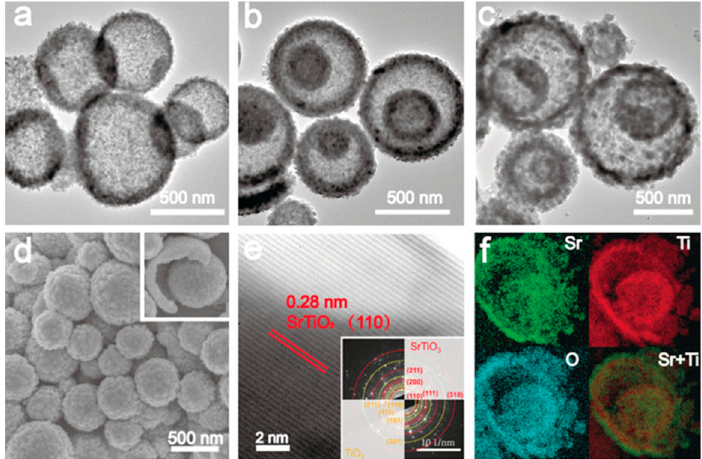
Figure 30. Morphological characterization of hollow multi ‐ shelled structures (HoMSs): TEM images of ( a ) single (1S ‐ ), ( b ) double (2S ‐ ), and ( c ) triple (3S ‐ ) shelled structures. ( d ) SEM image of 3S ‐ HoMSs (inset: broken sphere). ( e ) HRTEM image of SAED of S ‐ HoMSs (S ‐ HoMSs). ( f ) Elemental mapping of a slice of S ‐ HoMSs, after 12 h of hydrothermal reaction. Reproduced from [101], with permission from John Wiley and Sons, copyright 2019.